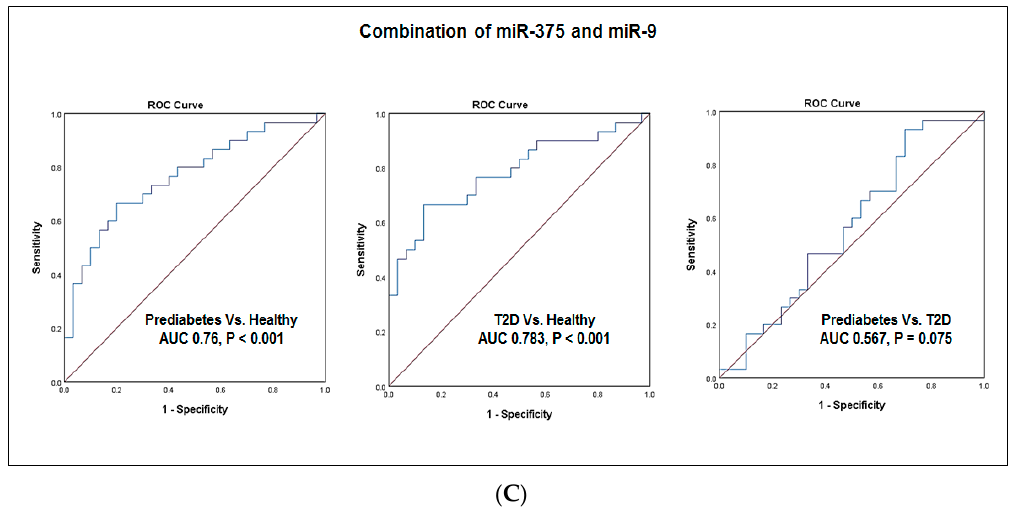
Figure 2. Receiver operating characteristic curve analysis. Receiver operating characteristic (ROC) curves were constructed to evaluate the diagnostic values of miR-375 and miR-9 as biomarkers for prediabetes and T2D. ( A ) ROC curves for miR-375. ( B ) ROC curves for miR-9. ( C ) ROC curves for combination of miR-375 with miR-9.